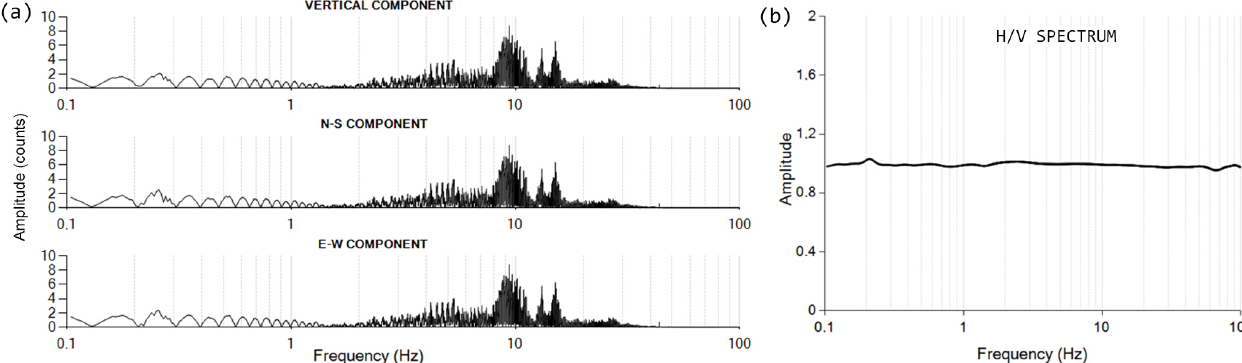
Figure 6. (a) Fourier spectra for the recorded three-component data during the second channel consistency test; (b) H / V spectral ratio.